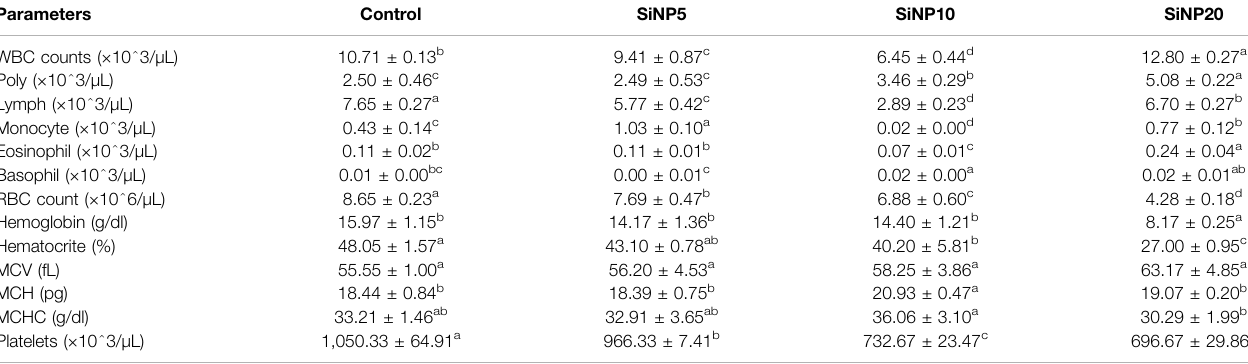
TABLE 4 | Hematological indicesofratsafter 96-h gavage with differentlevelsofsilica nanoparticles including zero (as thecontrol),5(SiNP5), 10(SiNP10), and 20(SiNP20). Parameters